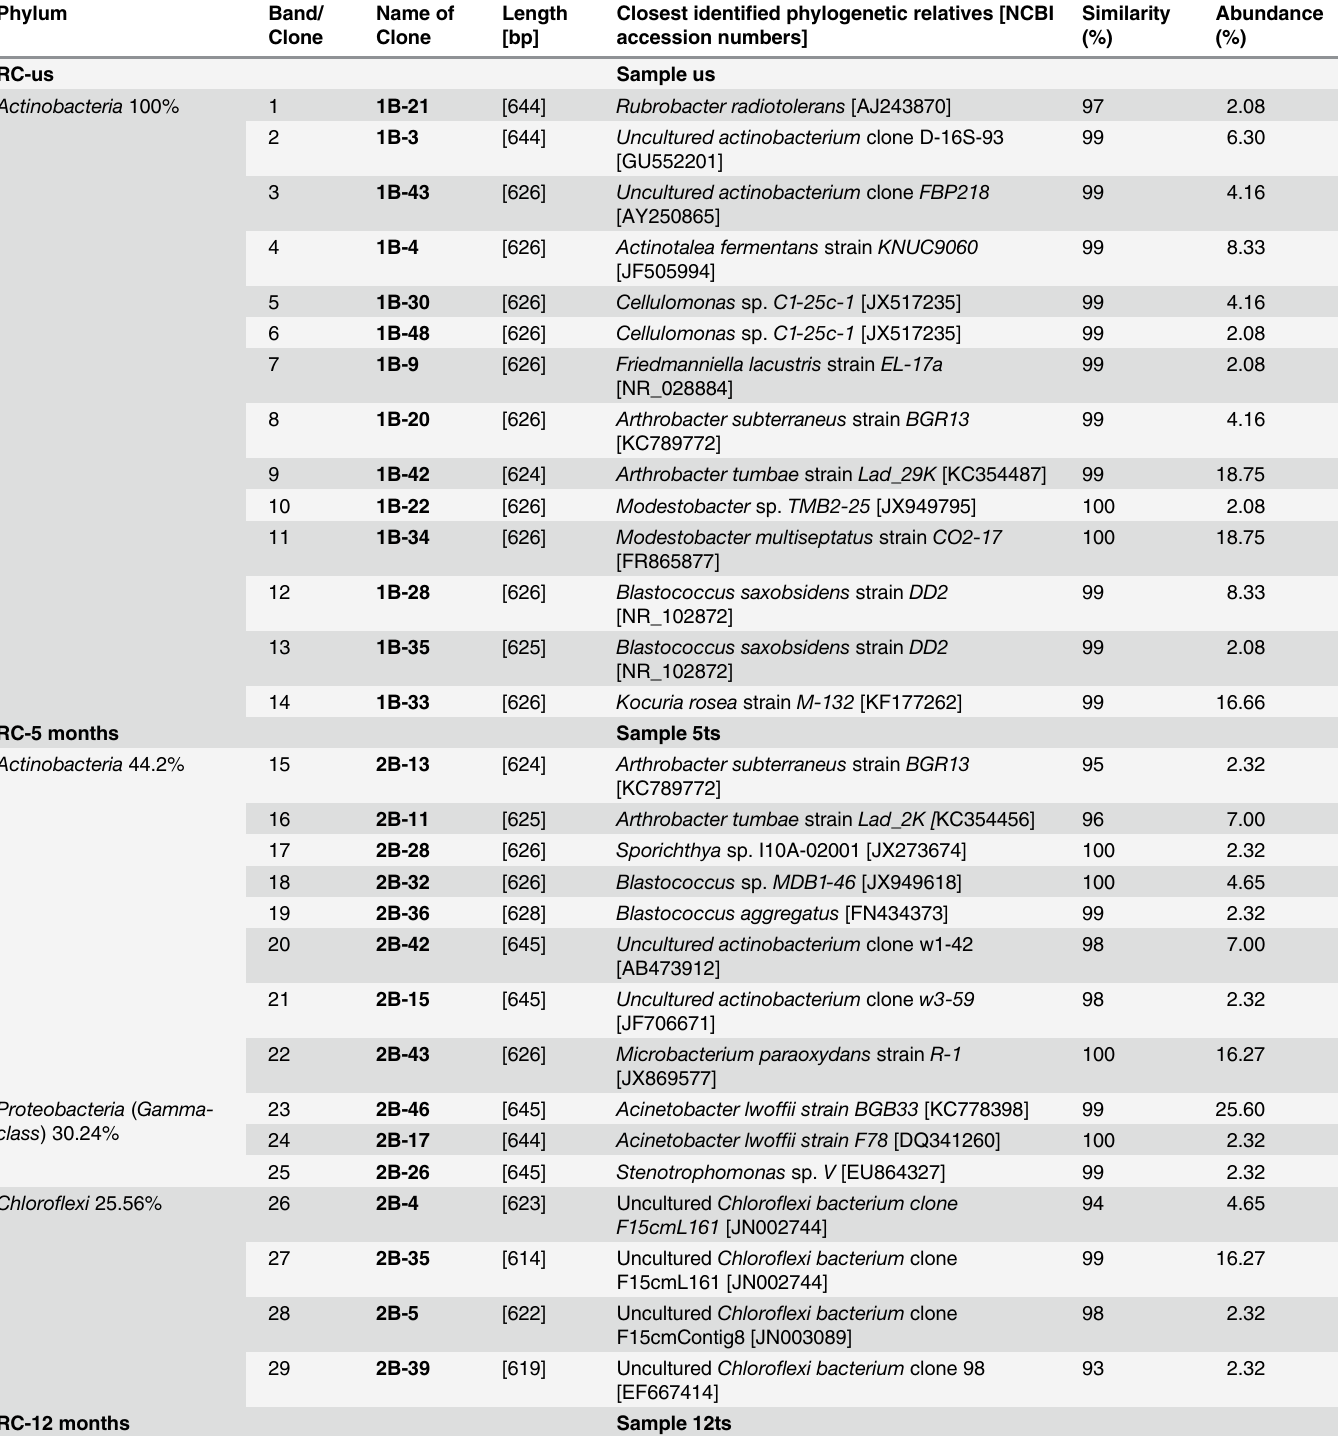
Table 1. Description of the different bacterial clones obtained from untreated (us) and treated stones at five, twelve and thirty months after the application of the bio-consolidation treatment at the Royal Chapel (RC) in Granada. Clones numbers and calculated percentages show the sequenced clones amount related to the corresponding genus/species and